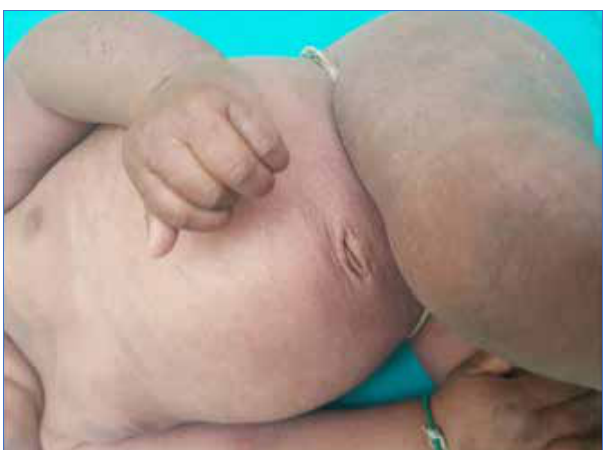
Figure 5: Atopic dermatitis in an infant